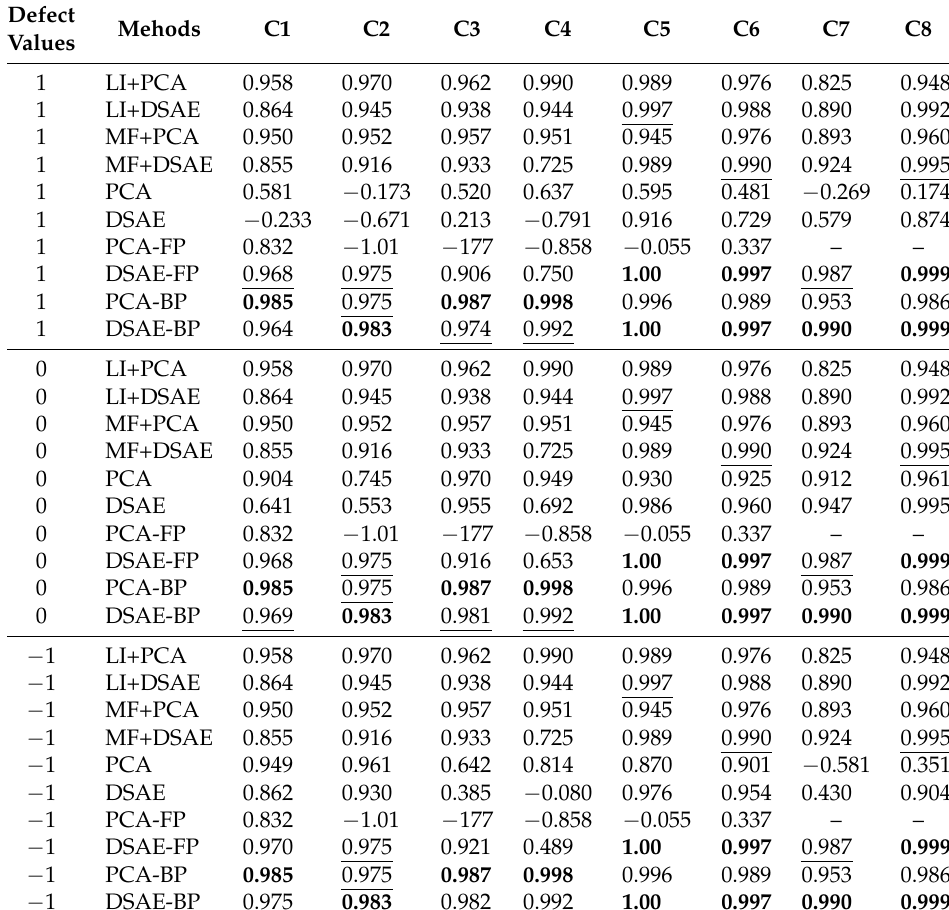
Table 4. R 2 s between the extracted time-series of latent features of D12 and C1 to C8. The highest value of R 2 is presented in bold font; the second highest value is underlined for each defect